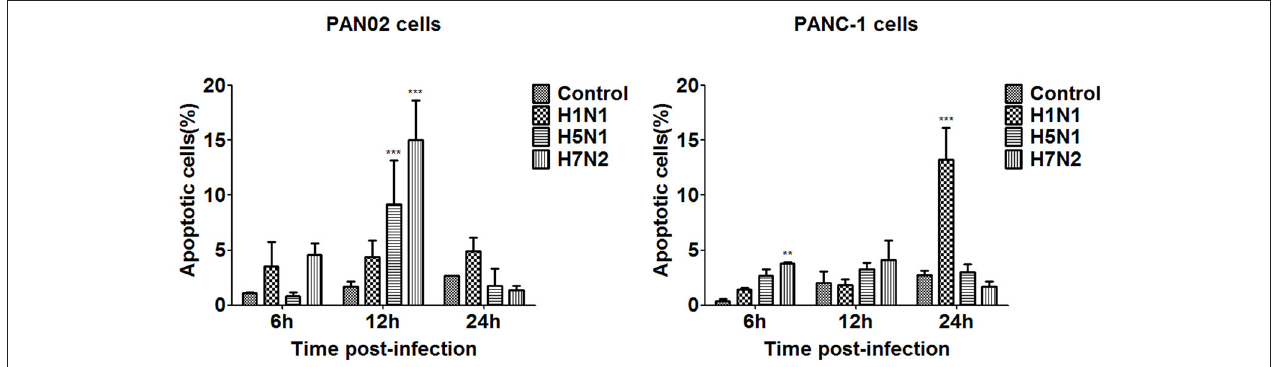
FIGURE 7 | Pancreatic cell apoptosis was measured at specified times following IAV infection. PAN02 and PANC-1 cells were mock-treated or infected with IAV (H1N1, H5N1, or H7N2) at an MOI of 1, taxol served as a positive control. Then the cells were harvested at 6, 12, and 24h post-infection. The total number of apoptotic cells in early stage was analyzed by flow cytometry. Asterisks indicate statistically significantly values compared with mock-treated cells (** P < 0.01, and *** P <